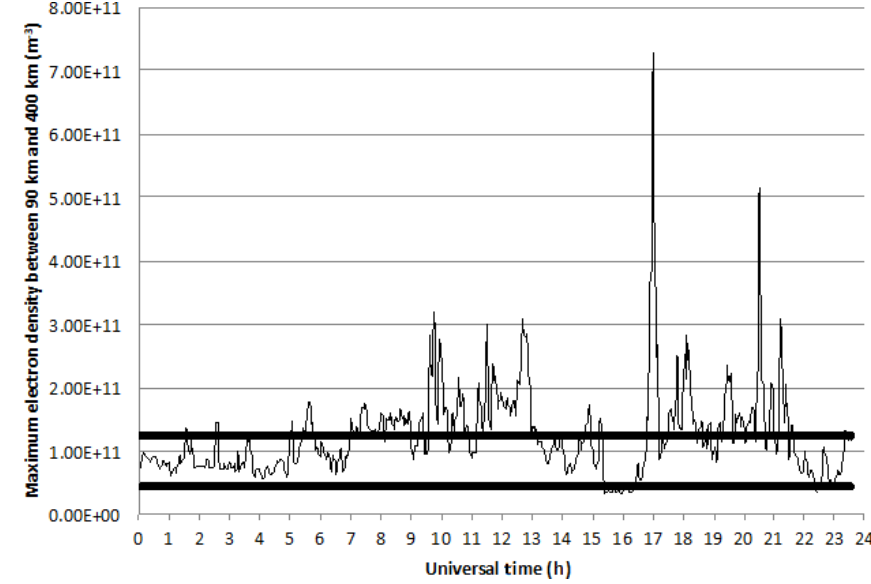
Figure 9. As in Fig. 4 but for 10 December 2015. A polar hole can be seen between 15:24 and